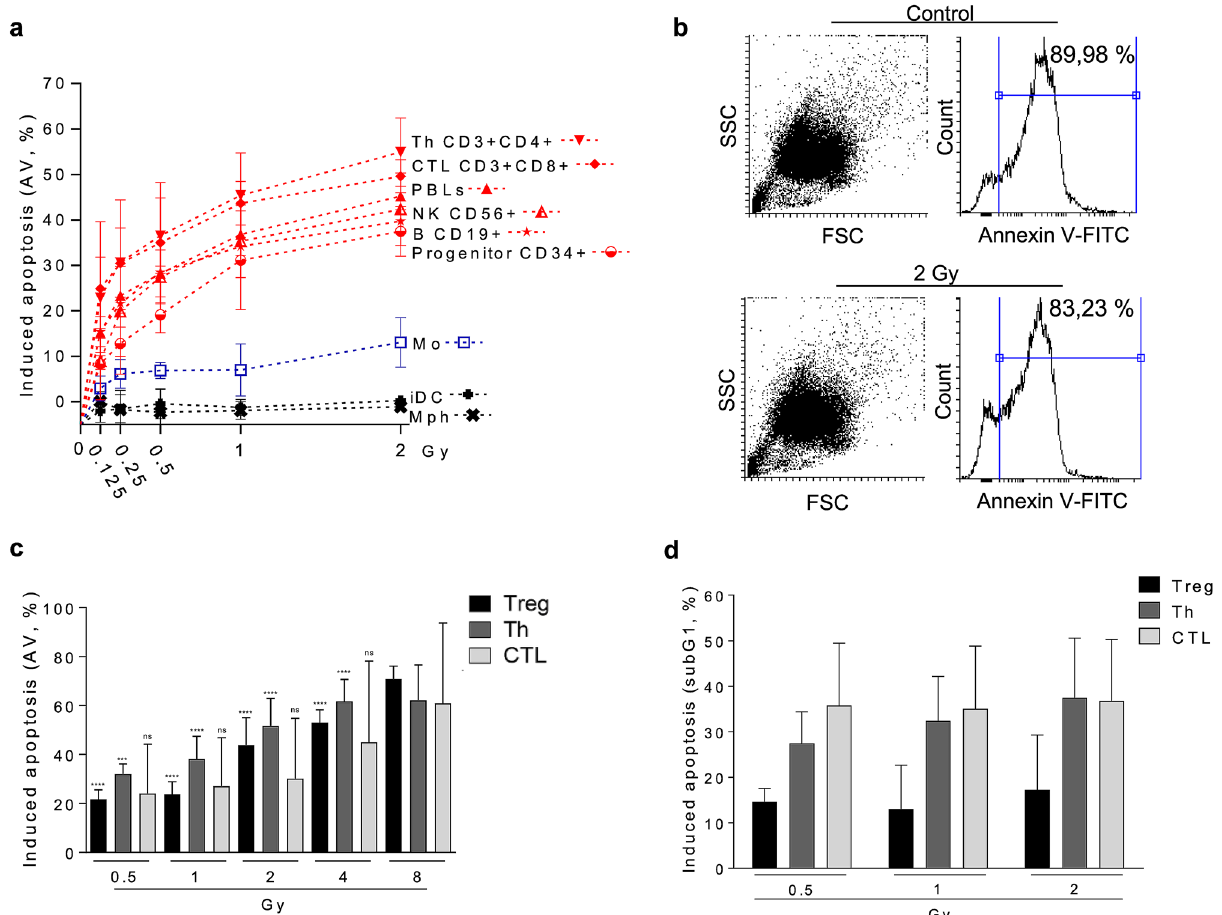
Figure 1. Radiation-induced cell death of different blood cells from the myeloid and lymphoid lineage. ( a ) After radiation treatment, significantly more cells of the lymphoid lineage (Th, CTL, NK cells, B cells and CD34 progenitor cells) undergo radiation-induced cell death compared to monocytes and the radioresistant iDC and Mph. Apoptosis was determined by annexin V-flow cytometry 24 h after treatment. Mean value, SD, n = 3. Data for Th, CTL, PBLs and CD34+ are from ref 8 where they were shown in a different context. ( b ) Granulocytes showed already a high basal level of cell death, independent from radiation treatment, as revealed by annexin V-staining. ( c ) Radiation-induced cell death of Treg, Th and CTL purified with magnetic beads. Data for 0.5 and 1 Gy are from ref 8 . At 0.5 Gy, regulatory T cells are more resistant to IR compared to Th. CTL showed high interexperimental variations. Mean value, SD, n = 3. The induced frequencies were significantly above the control levels (which are shown in Fig. S1c), ns, not significant; * p < 0.05, ** p < 0.01. ( d ) Radiation-induced apoptotic DNA fragmentation in Treg, Th and CTL as analysed by the subG1-assay. There was a tendency for Treg to undergo less DNA fragmentation than Th and CTL. Mean value +/− SD, n =